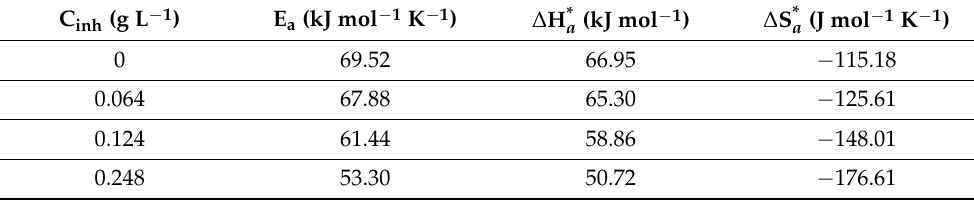
Table 2. Thermodynamic properties E a , ∆ H ∗ a and ∆ S ∗ a (see definitions in text) for aluminum in 0.1 M HCl blank solution and in the blank solution with different concentrations of Ilex paraguariensis